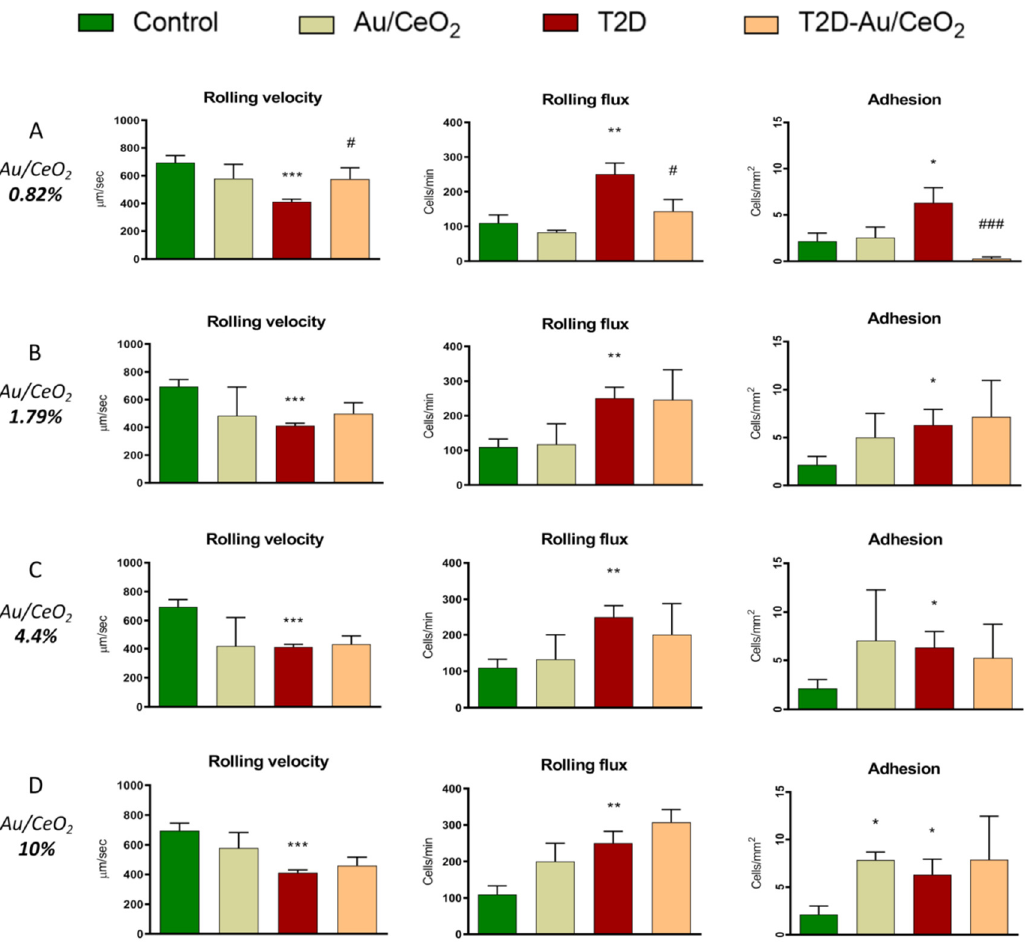
Figure 5. Evaluation of leukocyte–endothelium interaction in presence and absence of Au/CeO 2 (3 h, 0.02 mg/mL) in T2D patients and control subjects. Rolling velocity (µm second − 1 ), rolling flux (leukocytes per minute) and adhesion (leukocytes per square millimetre). * p < 0.05 vs. control ** p < 0.01 vs. control; *** p < 0.001 vs. control. # p < 0.05 vs DM2; ### p < 0.001 vs DM2.